Question: State the chart type depicted above.
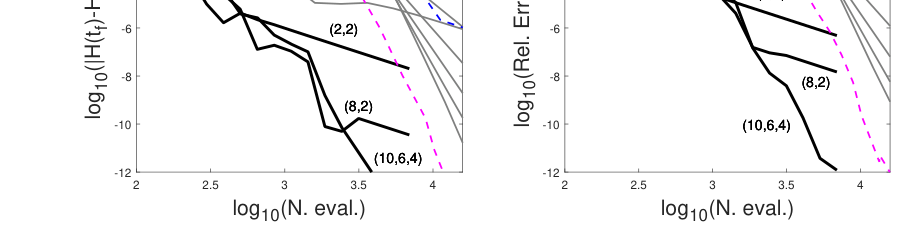
Answer: line